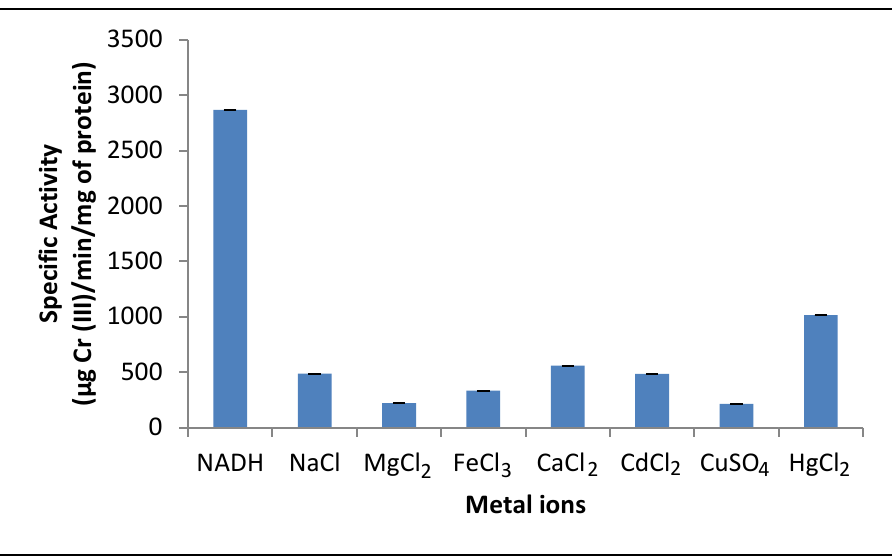
Figure 5. Effect of metal ions on crude reductant activity in the mixed membrane fraction of Purpureocillium lilacinum . 1 h of incubation, pH 7.0, 100 rpm, and 37 ◦